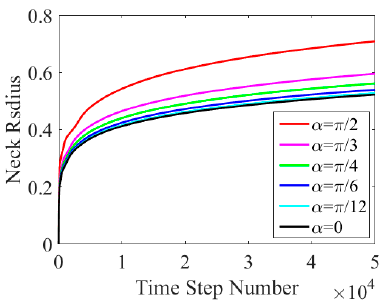
Figure 7. Sintering neck radii of two metal fibers with different fiber angles.